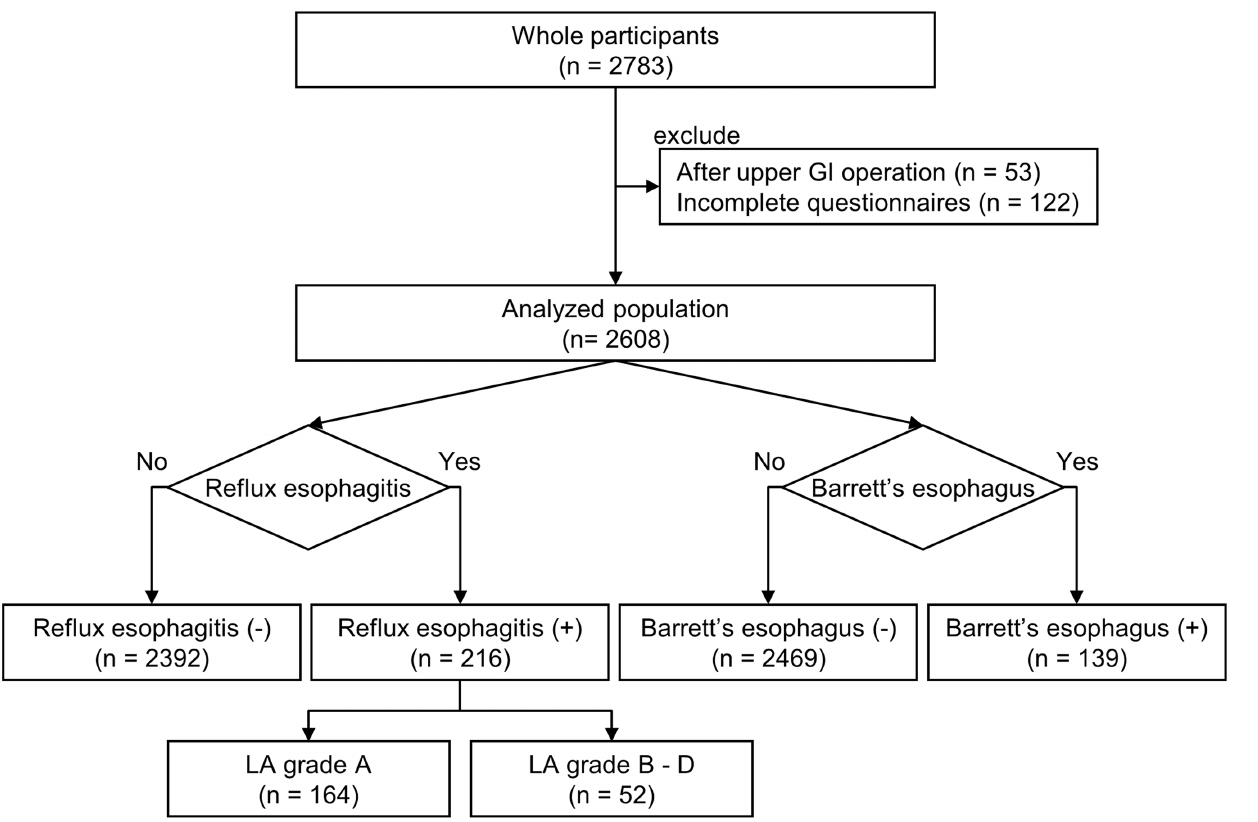
Fig 1. Diagram of inclusion of the study